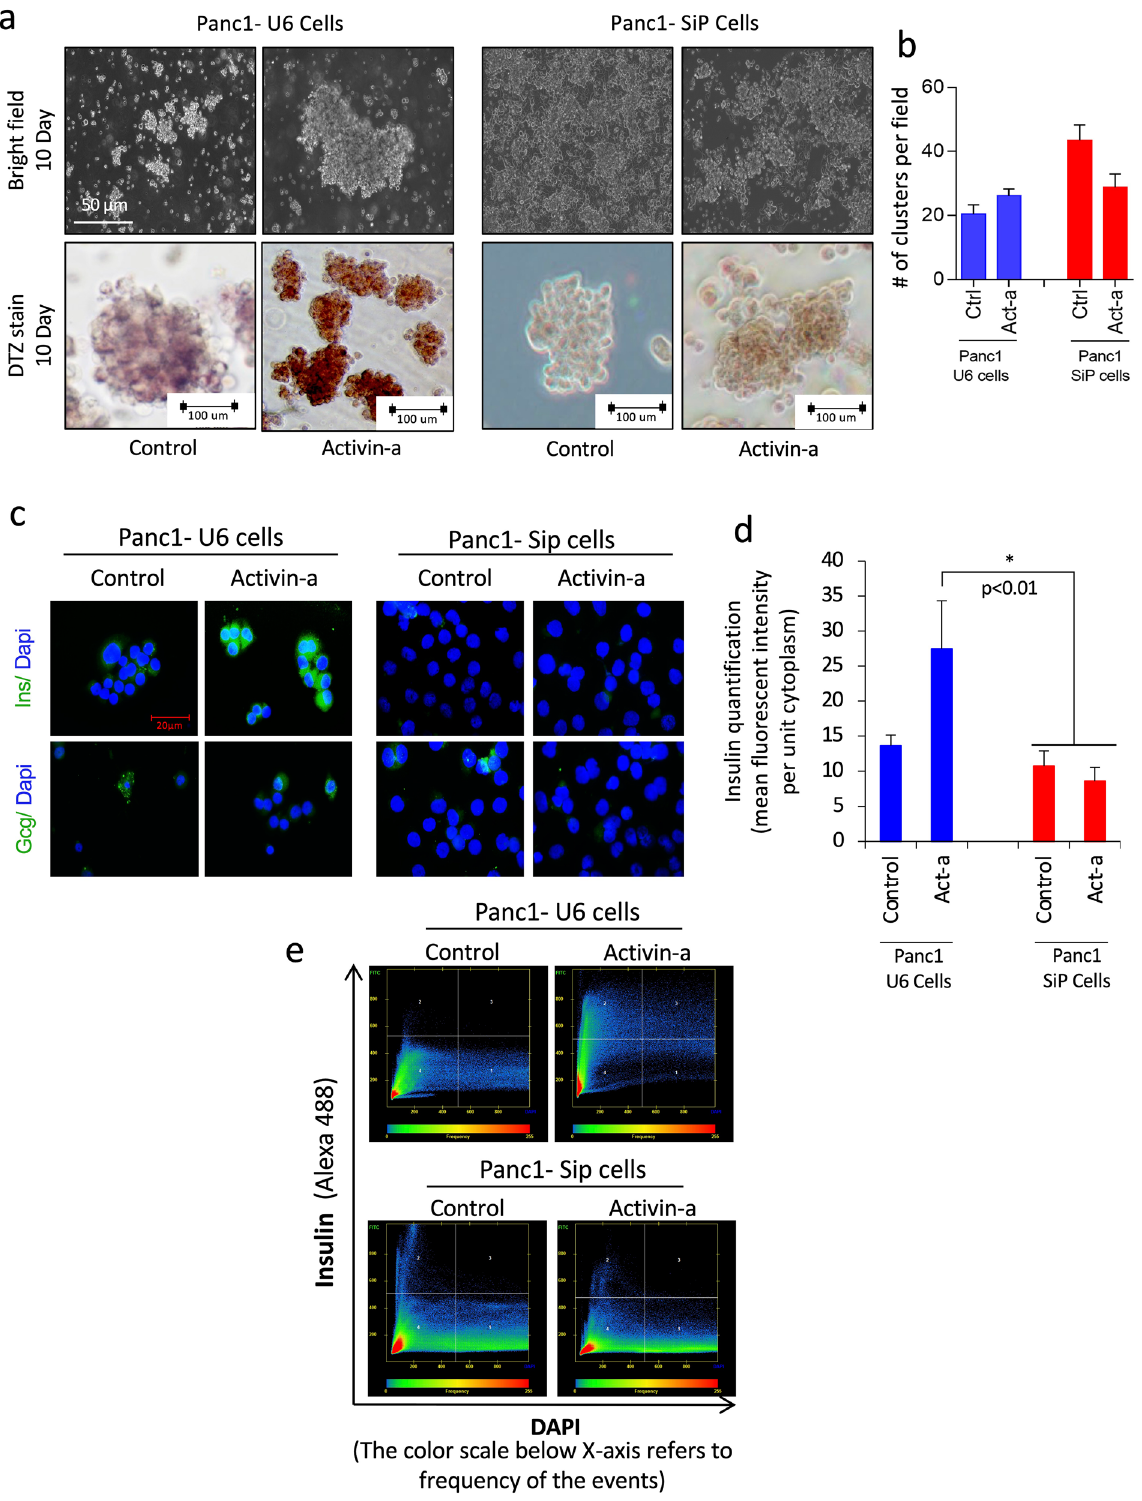
Figure 3. Islet cell differentiation and characterization for insulin production in PARP1 control and deplete PANC-1 cells. ( a ) Phase contrast microscopic images of PANC-1 U6/SiP cells differentiated with control (SFM) and activin-A on day 10th. Color brightfield images show the presence of brick-red insulin staining with dithizone (DTZ) after differentiation. ( b ) Graph show quantification for islet-like clusters generated per field of an image from PANC-1 U6/SiP cells at day 10th differentiation. ( c ) Immunocytochemical characterization of generated clustered from PANC-1 U6/SiP cells for islet cell markers- insulin and glucagon (green). ( d ) Quantification for mean fluorescence intensity for human insulin production in differentiated U6 and SiP cells. Data represented as mean ± sem, p-value show significance at 95% confidence interval using two-way anova analysis compared to U6 cells (n = 3). ( e ) Quantification and modelling for presence of insulin in U6 vs SiP cells using 2-dimensional mean fluorescent intensity dot plot representation extracted from immunostained images with Axio-vision Zen 10 software, Zeiss, Canada, where insulin stays on Y-axis and dapi is marked on